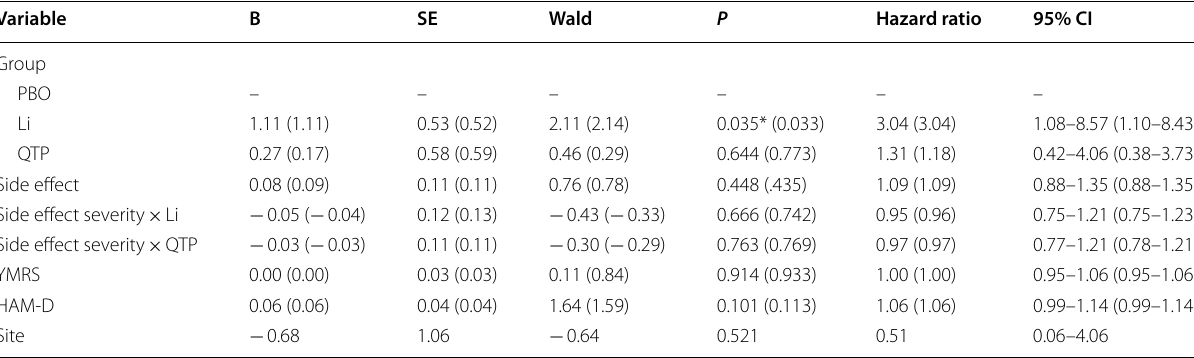
Table 6 Cox regression on retention for monotherapy versus individual combination